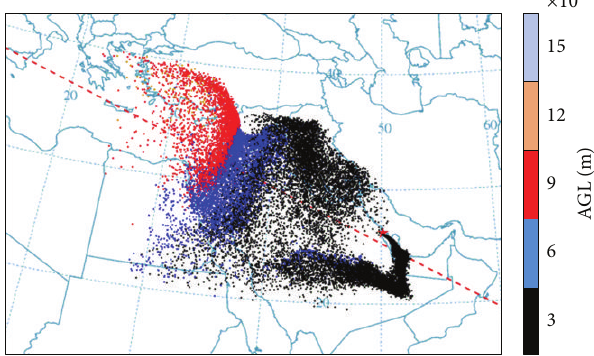
Figure 10: HYSPLIT backward trajectory dispersion starting from region 3 on March 09, 2009 16:00UTC for 3 days. Heights are indicated by the legend bar.